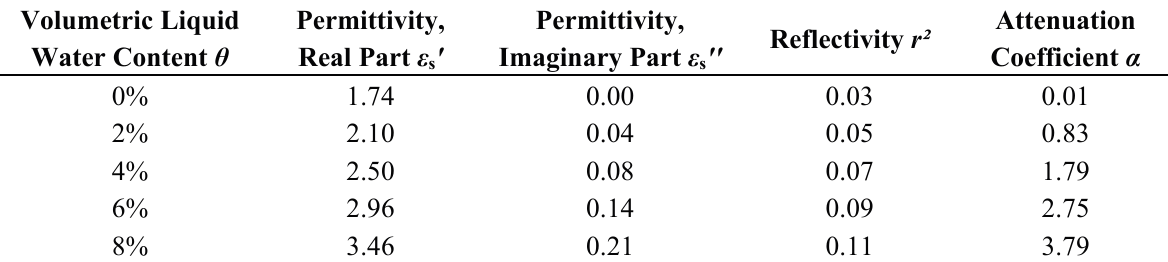
Table 1. Real ε (cid:3046)(cid:4593) and imaginary part ε (cid:3046)(cid:4593)(cid:4593) of the complex permittivity of snow, corresponding reflectivity r ² and the attenuation coefficients α for varying values of LWC; LWC is the mean of the three approaches for the real part (Equations (13), (14) and